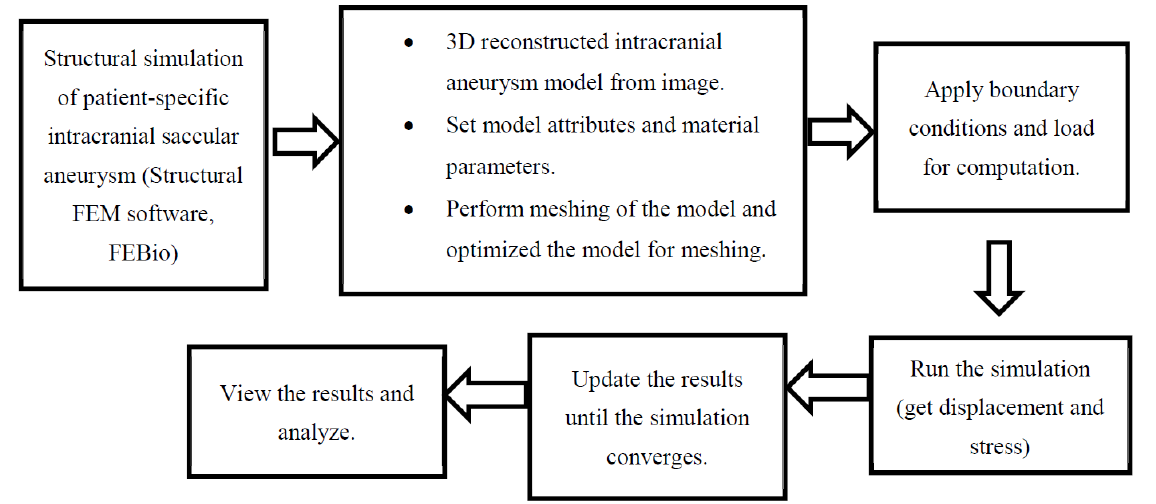
Figure 1. Steps of finite element simulation of unruptured intracranial aneurysms in